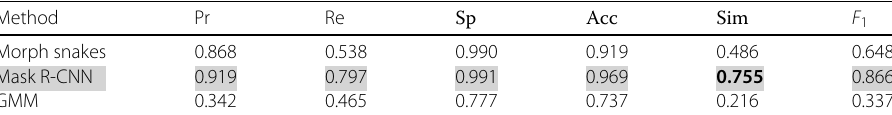
Table 10 Summary of the best evaluation result for each implemented method Method Pr Re Sp Acc Morph